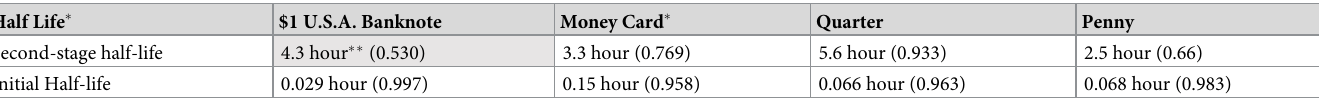
Table 1. Apparent two-step half-life of SARS-CoV-2 on various forms of currency. Half Life